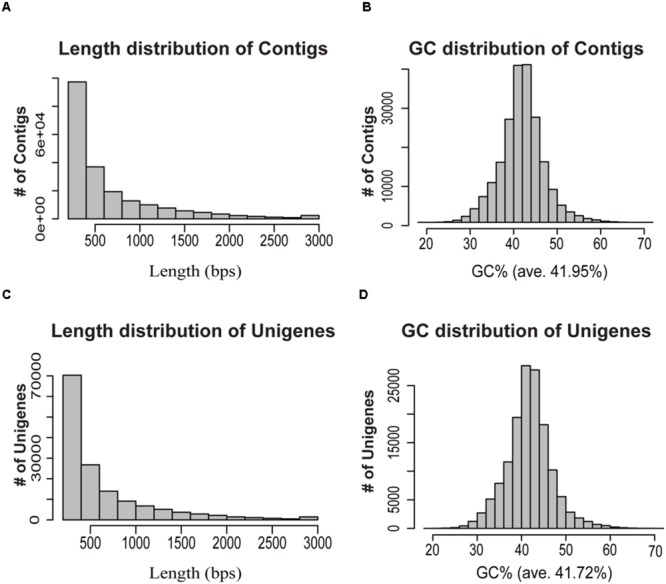
Overview of the de novo transcriptome assembly in P. japonicus. (A,B) represents length and GC distribution of contigs assembled from all cleaned reads from five tissues of P. japonicus using Trinity program (Grabherr et al., 2011), (C,D) represents length and GC distribution of unigenes generated from further contigs assembly.